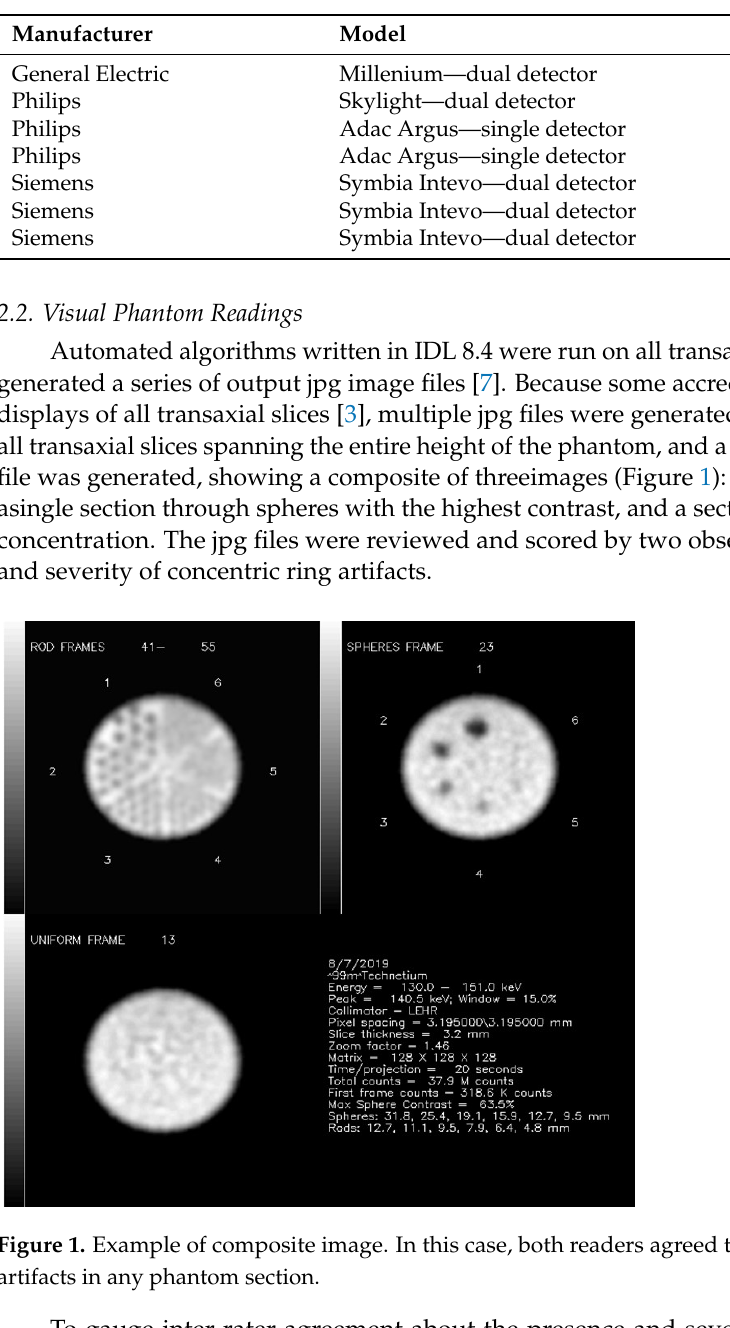
Table 1. SPECT systems and related number of studies selected for concentrinc ring artifact evaluation.